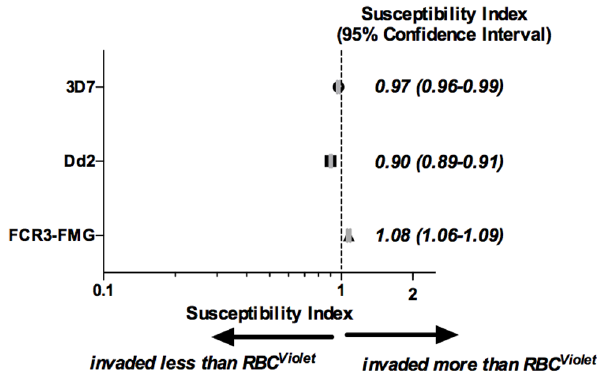
Figure 2. Direct comparison of P.falciparum strains 3D7, Dd2 and FCR3-FMG invasion into RBCs barcoded with DDAO and CellTrace Violet. Equal numbers (1 6 10 7 ) of RBCs stained with either 5 m M CellTrace DDAO (RBC DDAO ) or CellTrace Violet (RBC Violet ) were combined (total of 2 6 10 7 RBCs per well) and inoculated with 2 6 10 5 MACS purified trophozoite stage P. falciparum strains 3D7, Dd2 or FCR3- FMG. Invasion experiments were incubated 18–24 hours to allow for rupture of schizonts and subsequent invasion of merozoites into labeled RBCs, then stained with DNA dye SYBR Green I (to identify pRBCs), fixed and analyzed by flow cytometry. The Susceptibility Index (SI), an unadjusted Odds Ratio assessing the relative risk of RBC DDAO and RBC Violet to 3D7, Dd2, and FCR3-FMG invasion. The marker represents the SI point estimate and the bar represents the 95% confidence interval (CI). A SI of 1.0 indicates no difference in parasite invasion of two RBC populations. Data is the combination of four, seven, and three independent experiments performed in triplicate with 3D7, Dd2, and FCR3-FMG respectively.